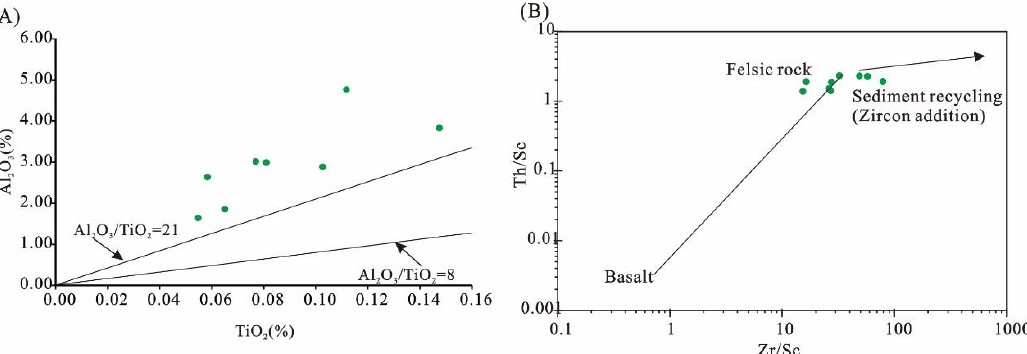
Figure 13. Plot of ( A ) TiO 2 vs. Al 2 O 3 and ( B ) Zr/Sc vs. Th/Sc for coal samples from the Junde mine.